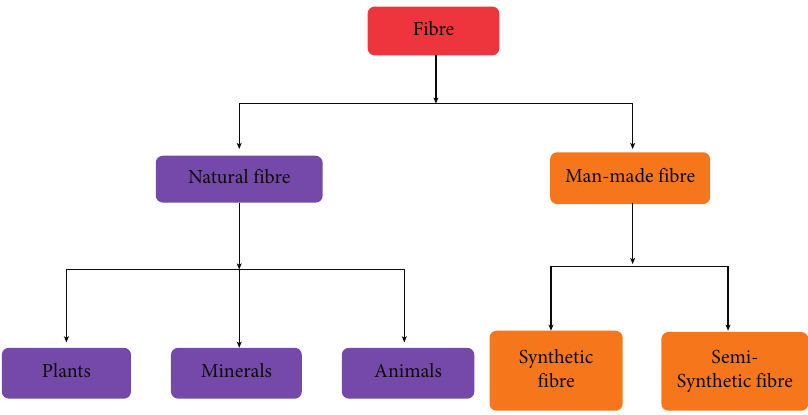
Figure 2: Types of